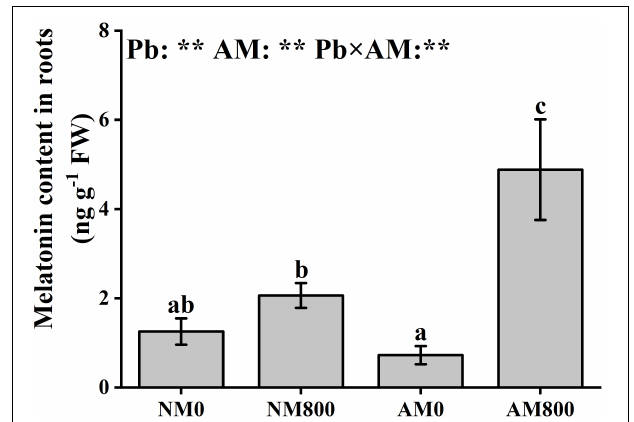
FIGURE 1 | The melatonin content of mycorrhizal roots under Pb stress. The data are the means ± standard deviation ( n = 4). Different letters above the columns indicate significant difference among the means of melatonin content by Tukey HSD’s test ( P < 0.05), respectively. AM = AM inoculation; Pb = lead stress; NM0 = non-AM inoculation in the absence of Pb treatment; NM800 = non-AM inoculation with 800 mg kg − 1 Pb treatment; AM0 = AM inoculation in the absence of Pb treatment; AM800 = AM inoculation with 800 mg kg − 1 Pb treatment. Significant effect of two-way ANOVA: ** P < 0.01; NS, not